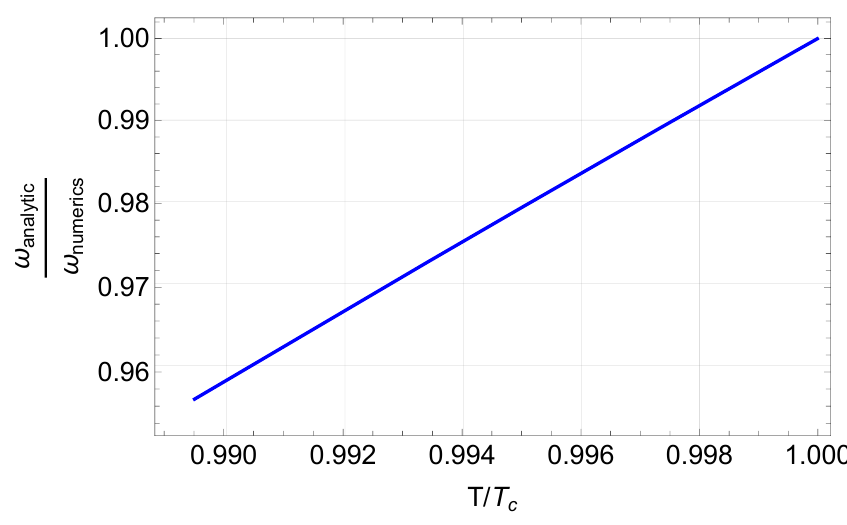
Figure 2 . Comparison of the analytic and numerical result for the gap for superfluids. Here φ s = 1 , q = 1 , µ = 1 , ζ ρ = 1 , ζ φ = 0 , λ ρ = 1 , λ φ = 1 and λ = − 1